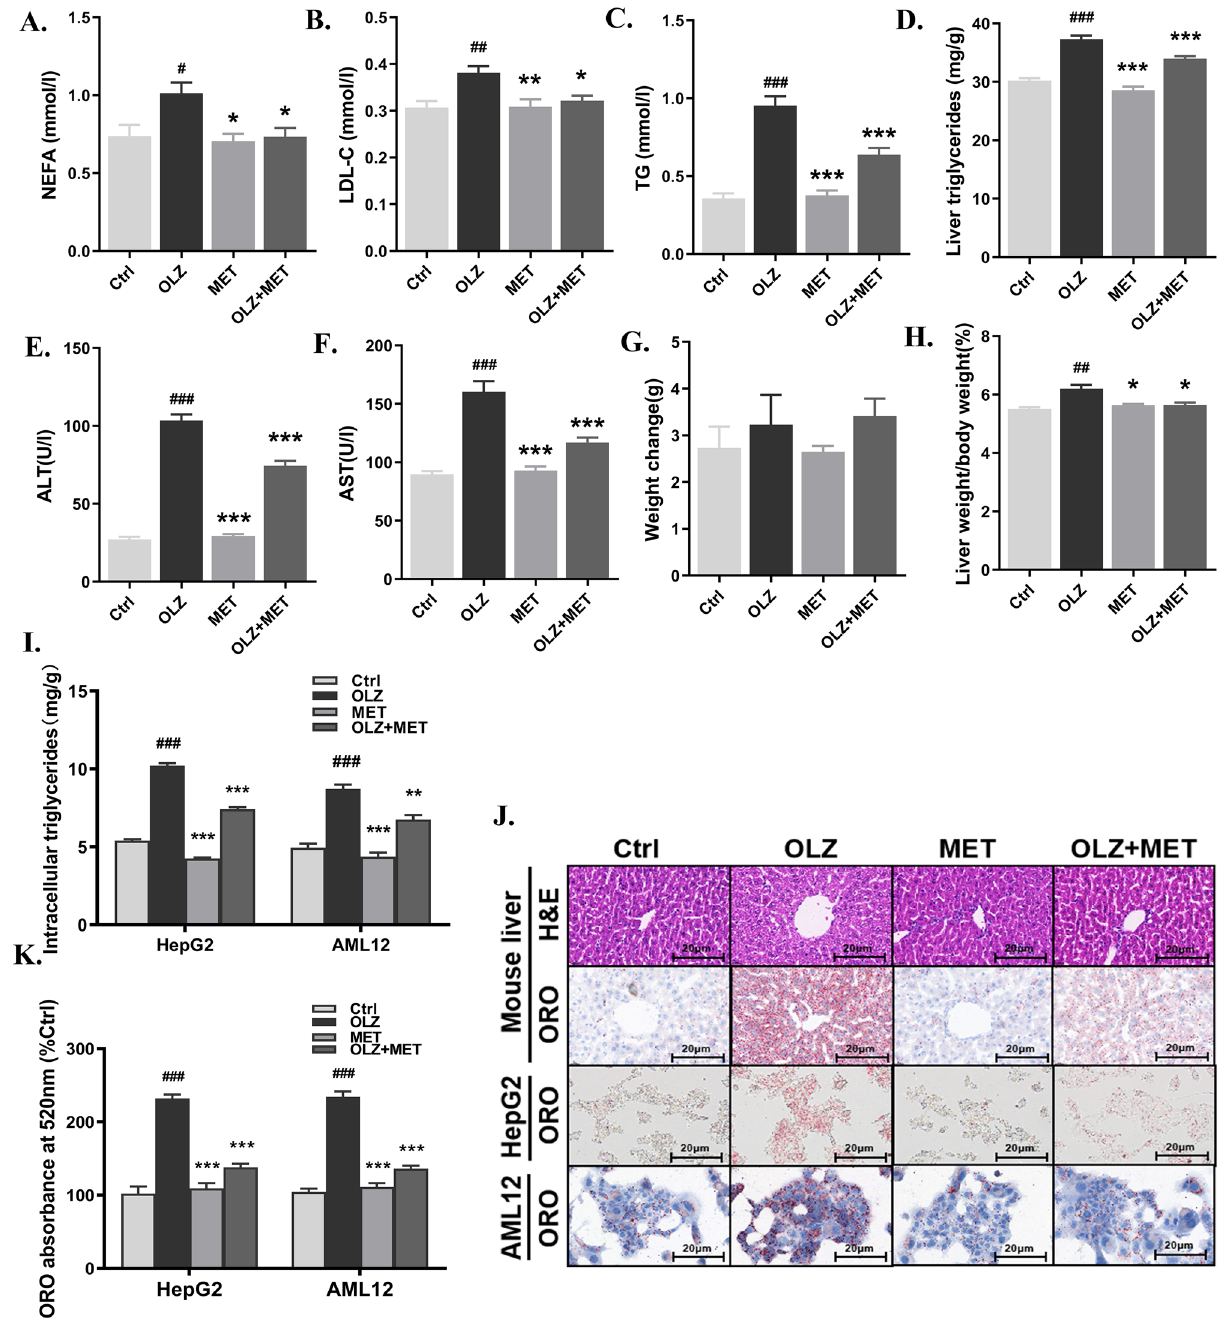
Figure 1. Metformin attenuates olanzapine-induced metabolic disturbance and hepatic/hepatocyte lipid accumulation in mice and cells. ( A ) Plasma NEFA levels. ( B ) Plasma LDL-C levels. ( C ) Plasma TG levels. ( D ) Liver triglyceride levels. ( E ) Plasma ALT levels. ( F ) Plasma AST levels. ( G ) Body weight. ( H ) Liver weight/ body weight ratio. ( I ) Triglyceride levels in HepG2 cells and AML12 cells. ( J ) H&E and ORO staining. ( K ) ORO absorbance at 520 nm in HepG2 cells and AML12 cells. Ctrl, control; OLZ, olanzapine; MET, metformin. Data represent the mean ± SEM. # p < 0.05, ## p < 0.01, ### p < 0.001 vs. control; * p < 0.05, ** p < 0.01, *** p < 0.001 vs. olanzapine; one-way ANOVA plus Tukey’s post-hoc liver weight as well as liver/body weight ratio, both of which were improved via co-treatment with olanzapine and metformin (Fig. 1G,H). Experiments with HepG2 cells and AML12 cells confirmed that the olanzapine- induced increase in triglycerides was effectively eliminated via metformin co-treatment (Fig. 1I). And CCK8 assays further showed that 100 μM olanzapine caused a decrease of cell activity and proliferation in HepG2 and AML12 cells (Fig. 1 in Supplementary materials), which might be attributed to the cytotoxicity at such high doses of olanzapine treatment and the effect of olanzapine-induced hepatic steatosis.